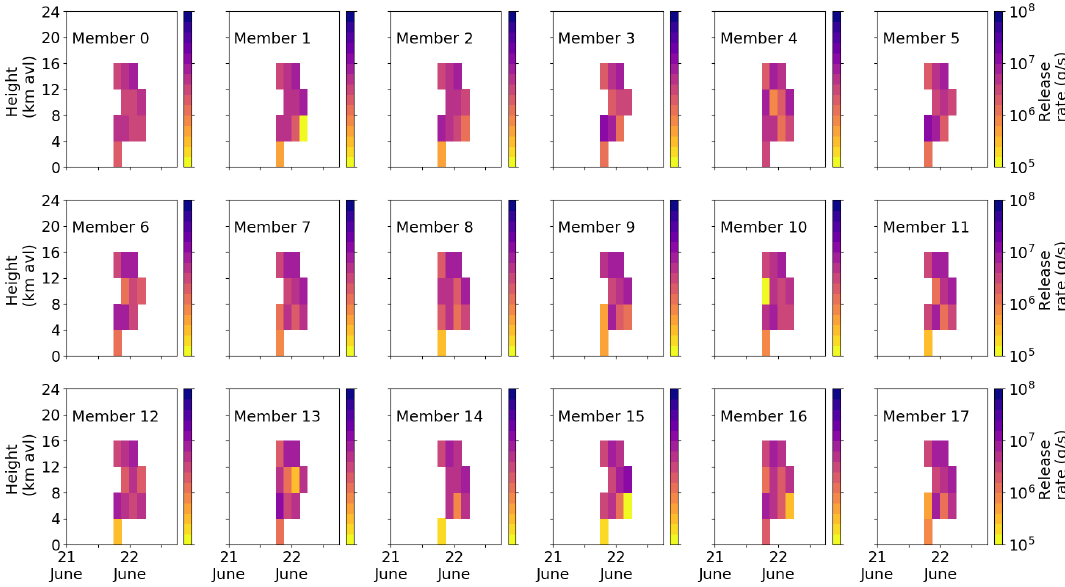
Figure 2. Posterior emission profiles (gs − 1 ) estimated by InTEM for the 2019 Raikoke eruption for each member of the MOGREPS-G ensemble, using Himawari retrievals of ash and clear skies. Note the logarithmic colour